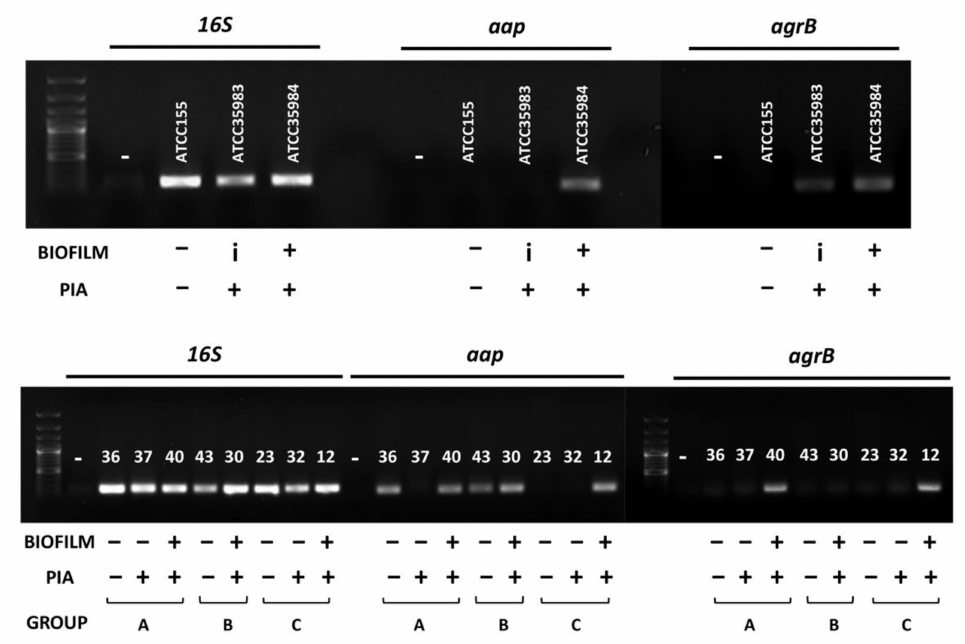
Figure 6. The PCR detection of aap and agrB genes in S. epidermidis clinical isolates. Agarose gel electrophoresis of PCR amplification of the 16S rRNA, aap and agrB genes in the S. epidermidis reference strains (upper panel) and clinical isolates (lower panel). The 100-bp DNA size ladder used as the molecular weight marker is shown on the left. The designation of each S. epidermidis strain/clinical isolate, and their phenotype with regard to biofilm formation, PIA production, and isolation source are